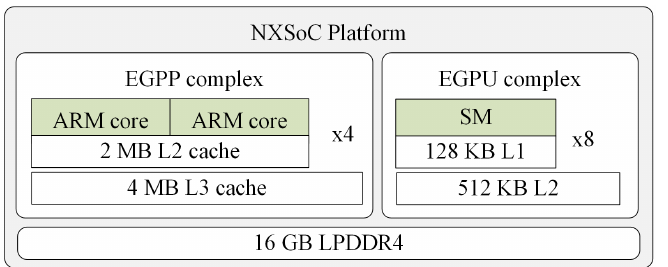
Figure 4. Representation of the architecture of the EGPP+EGPU platform, integrated by 8 EGPP cores, a GPU core with 8 SMs and shared